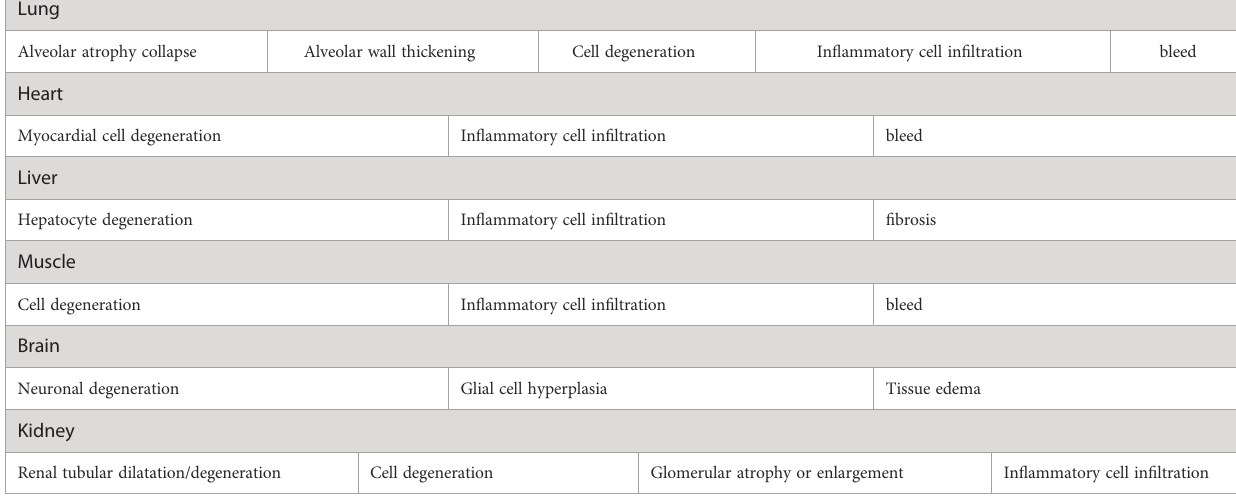
TABLE 1 Scoring standards of various tissues.